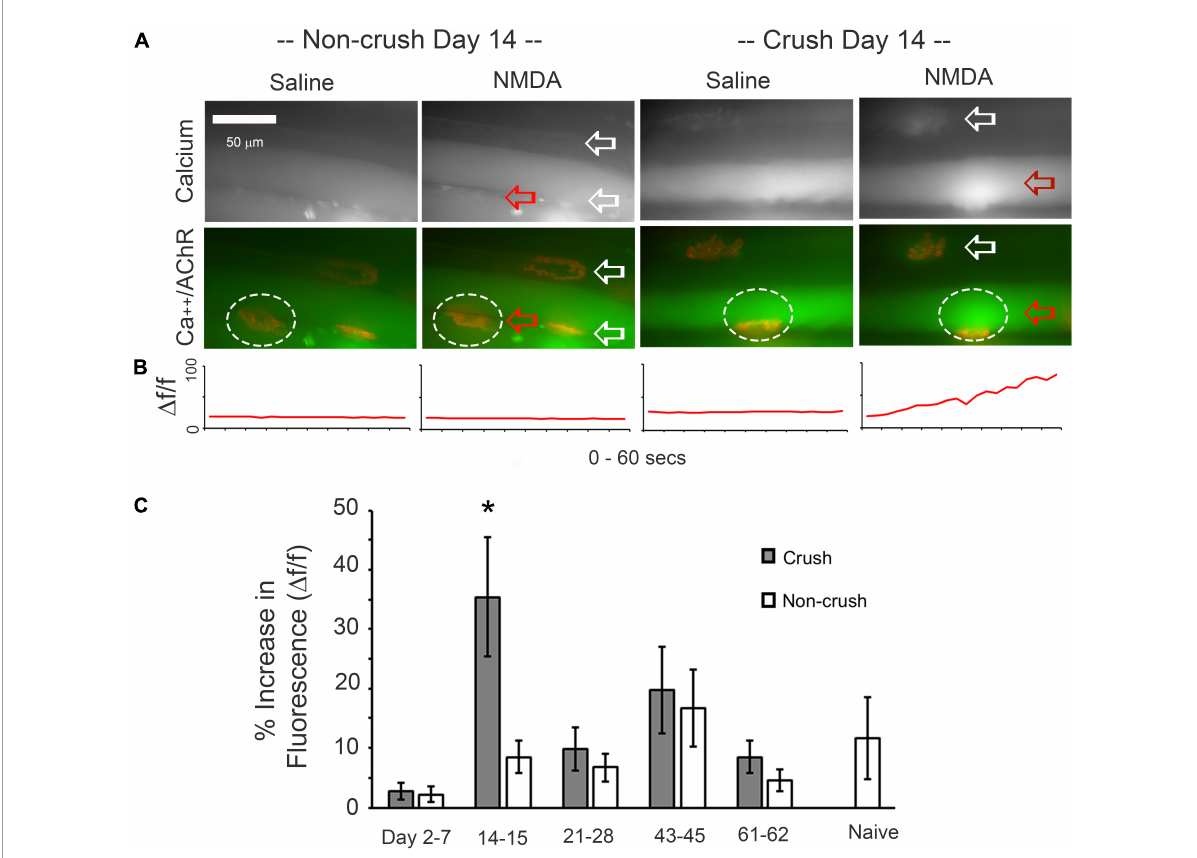
FIGURE2 Responses of soleus or extensor digitorum longus (EDL) muscle fibers to bath-applied NMDA. (A) Comparison of fibers contralateral to the nerve-crush limb and fibers from muscles at 14 days after nerve crush. Top row shows fluorescence of Fluo-4, with arrows pointing to ∝ -bungarotoxin labeling of endplates. Lower row shows merged channels illustrating the relationship of the rise in calcium to the location of endplates during a 30 s period of bath-perfused NMDA application, with ∝ -bungarotoxin-labeled ACh receptors shown in red. (B) Normalized change fluorescence over the 60 s bath-applied period for saline or NMDA for the NMJ region of interest (oval) indicated by the red arrow. (C) Normalized increase in fluorescence in response to NMDA at 2–62 days after nerve crush and in naïve muscles. Non-crush data are taken from the muscles contralateral to the nerve crush. A significant increase in Fluo-4 fluorescence was only seen at 14–15 days post-sciatic nerve crush (asterisk, p < 0.05, two-way t -test, n = 7–20